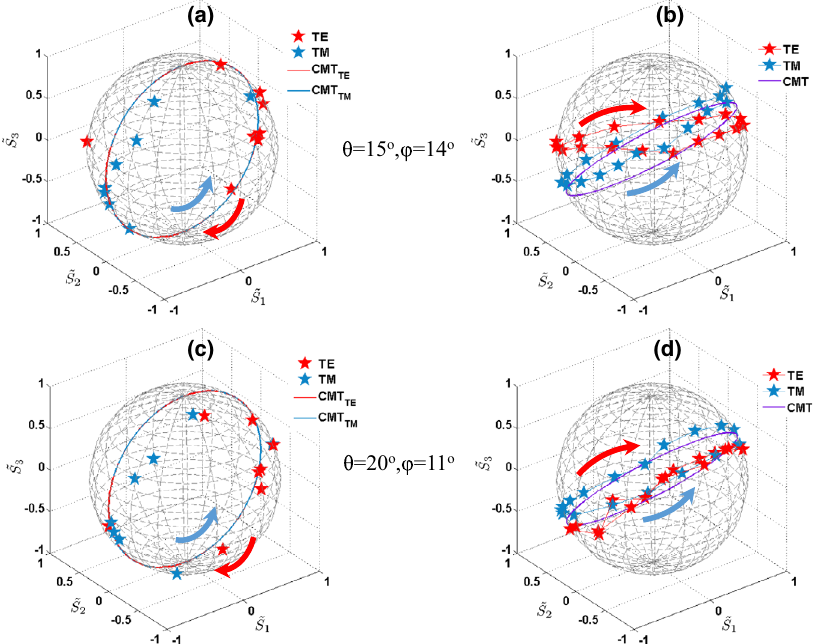
Fig. 6 Experimental veri fi cation of polarization manipulation and its coherent control. Experimental results for coherent polarization state evolution when varying the frequency under symmetric TE/TM incidence with a fi xed incident angle ð θ ¼ 15 o ; φ ¼ 14 o Þ ( a ) and ð θ ¼ 20 o ; φ ¼ 11 o Þ ( c ). Experimental coherent polarization state control when varying phase difference ψ under TE/TM incidence with a fi xed incident angle ð θ ¼ 15 o ; φ ¼ 14 o Þ ( b ) and ð θ ¼ 20 o ; φ ¼ 11 o Þ ( d ) at resonant frequency f ¼ 0 : 2656 THz.